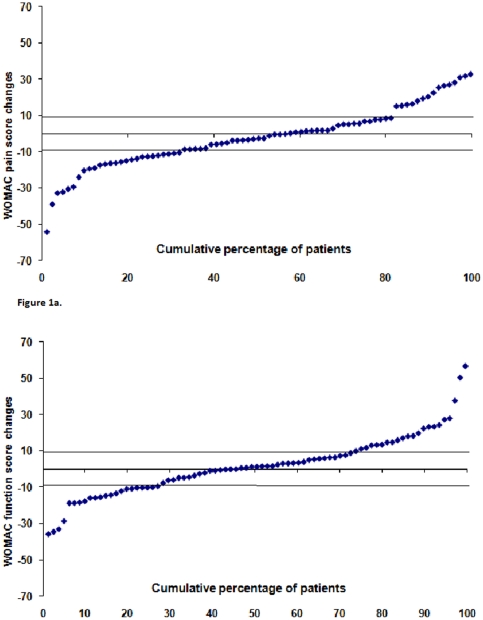
Cumulative probability plot of Western Ontario and McMaster Universities (WOMAC) scores change of patients without prosthesis during follow-up (n = 81) for WOMAC pain scores change (above) and WOMAC function scores change (below).The horizontal line above is the line set at minimal perceptible clinical improvement (MPCI) score which is used as the cut-off to define progression and the horizontal line below is the line set to define good prognosis.